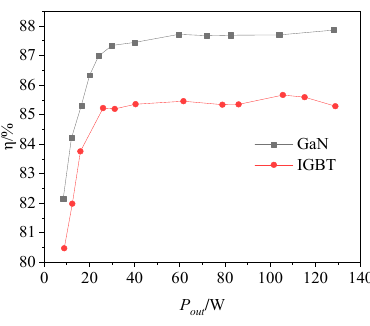
Figure 16. Buck circuit efficiency.